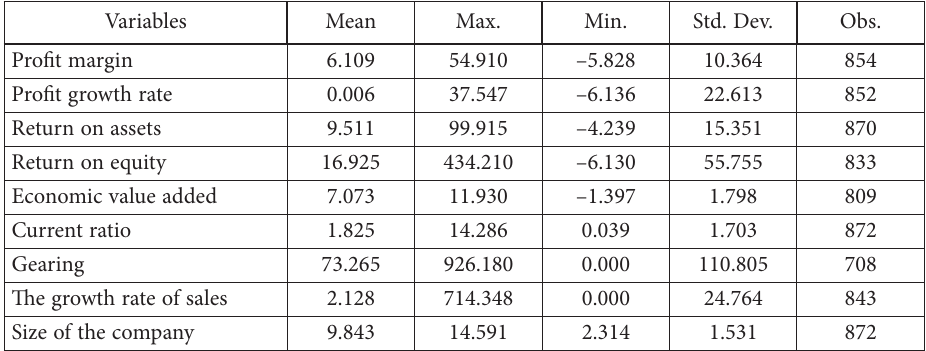
Table 3. Descriptive statistics of the variables (source: authors’ own